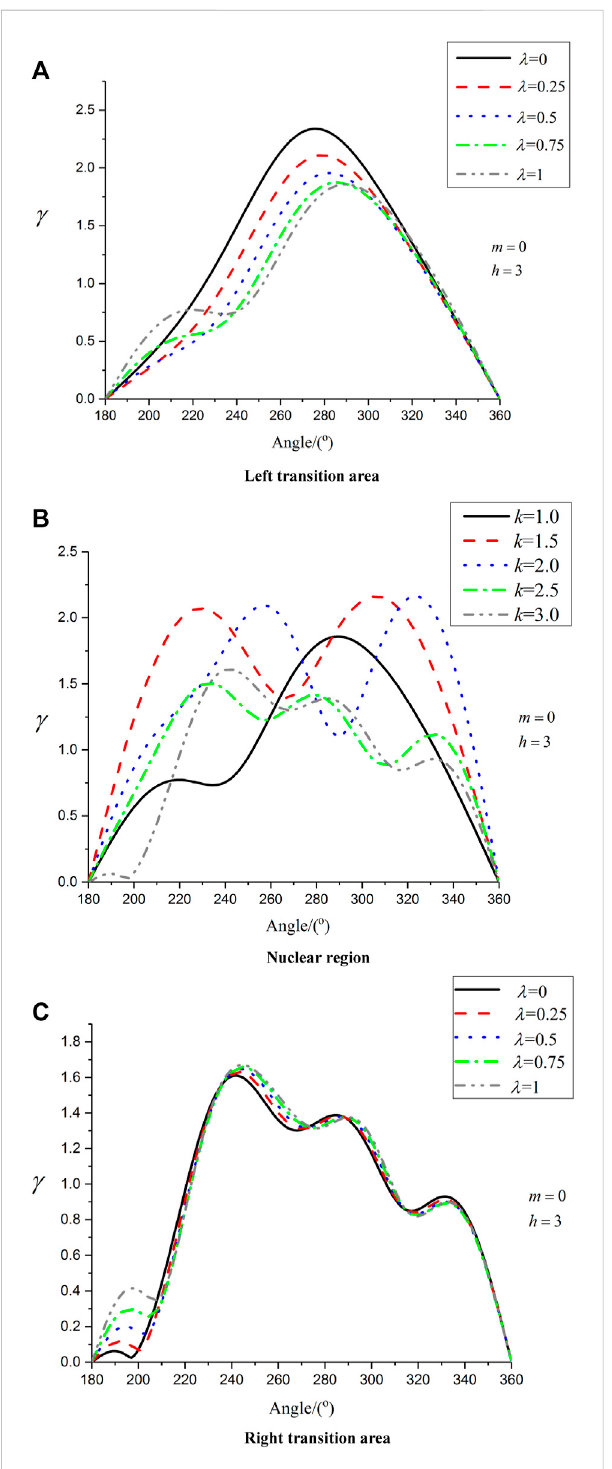
FIGURE 4 Distribution of hoop dynamic stress concentration factor of semi- circular depression when the thickness of the ribbon domain is h (cid:2) 6. (A – C) represent the results of these three subsets: Left transition area, Nuclear region and Right transition